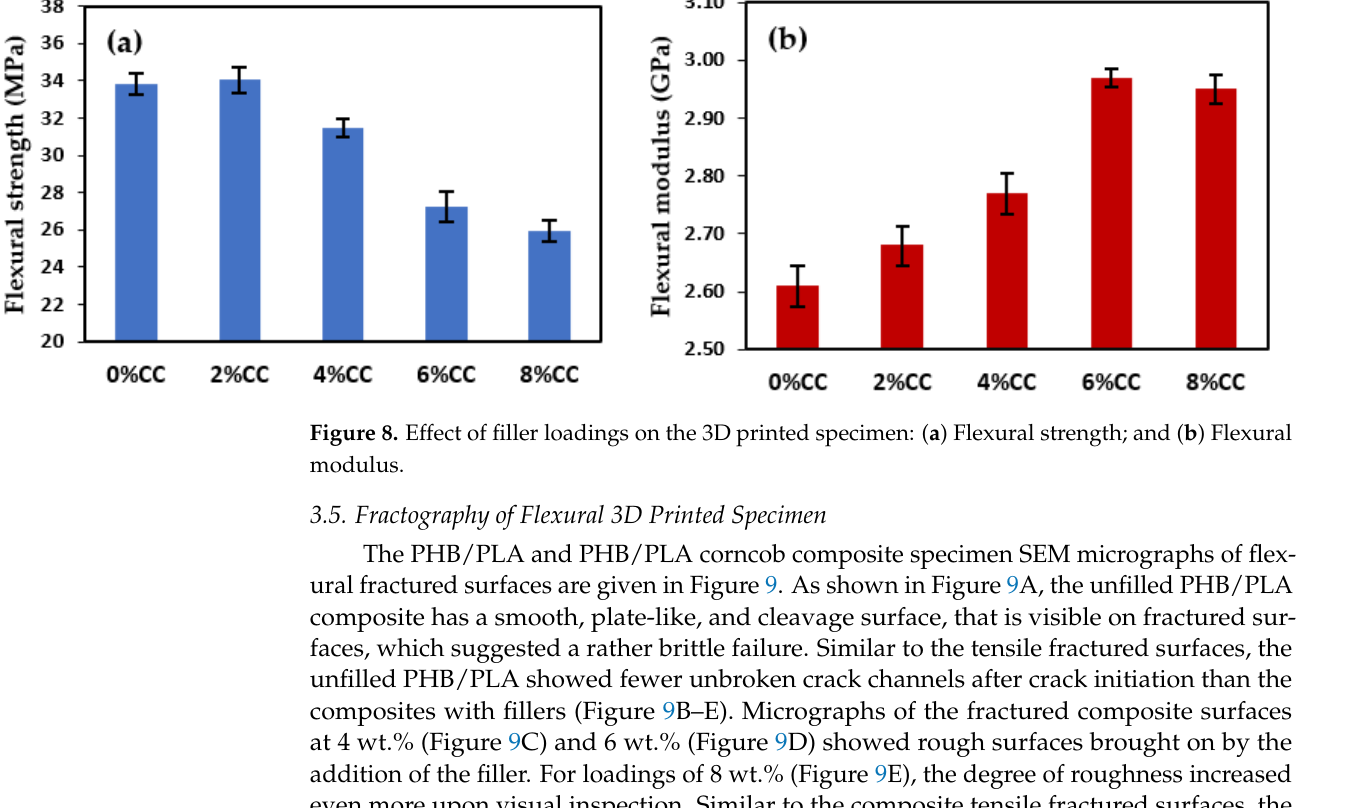
12 of 22 Figure 7. SEM micrographs of tensile test 3D printed test specimen fractured surfaces: ( A ) Denotes PHB (55%)/PLA (45%); ( B ) Denotes PHB (55%)/PLA (45%) + 2 wt.% CC; ( C ) Denotes PHB (55%)/PLA (45%) + 4 wt.% CC; ( D ) Denotes PHB (55%)/PLA (45%) + 6 wt.% CC; ( E ) Denotes PHB (55%)/PLA (4 5%) + 8 wt.% CC. 3.4. Flexural Properties of 3D Printed Specimens The flexural strength and modulus of PHB-PLA/corncob composite results are shown in Figure 8. The flexural strength and flexural modulus values for samples with 0 wt.% corncob was 34 MPa and 2.6 GPa, respectively. When these results were compared to the values provided in the literature for samples of pure PHB and pure PLA [60 – 62], they were found to be within the reported range. When a filler loading of 2 wt.% corncob was added, the flexural strength increased nominally by 1% compared to composites with 0